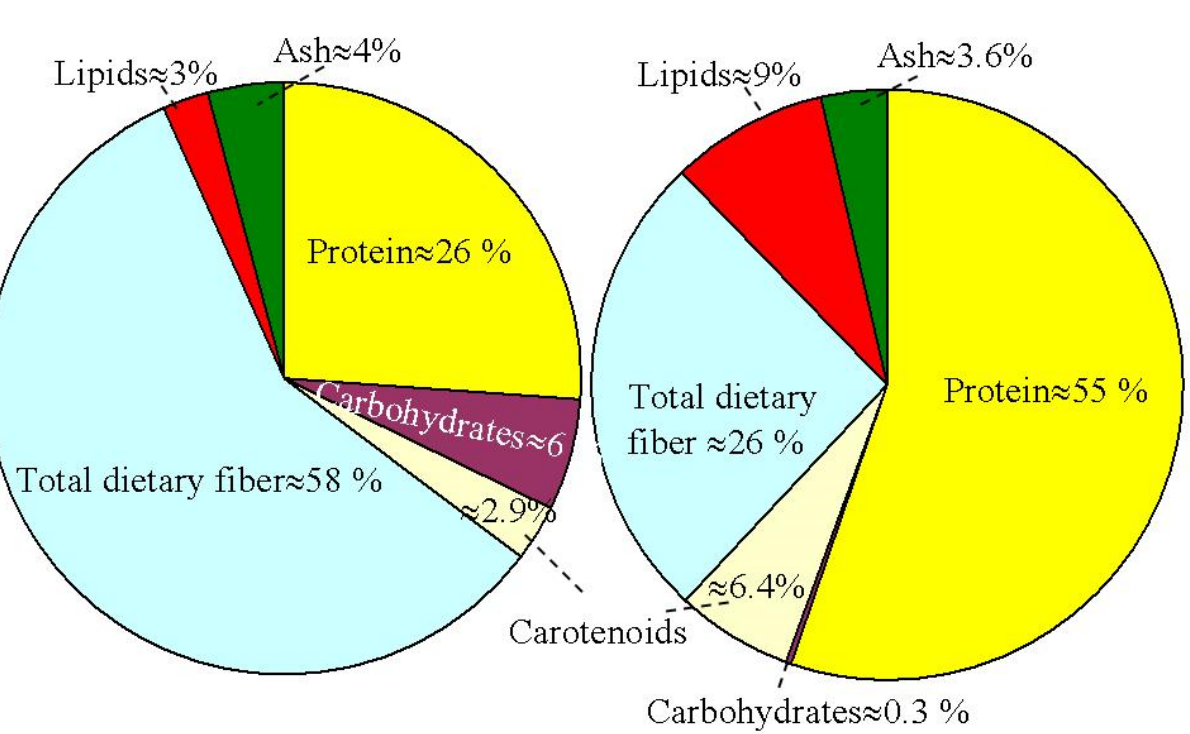
Figure 3. Initial biomass and supercritical CO 2 extract relative percentage proportions for different biomolecular component compositions in the H. pluvialis red phase. Based on the data obtained in [69].